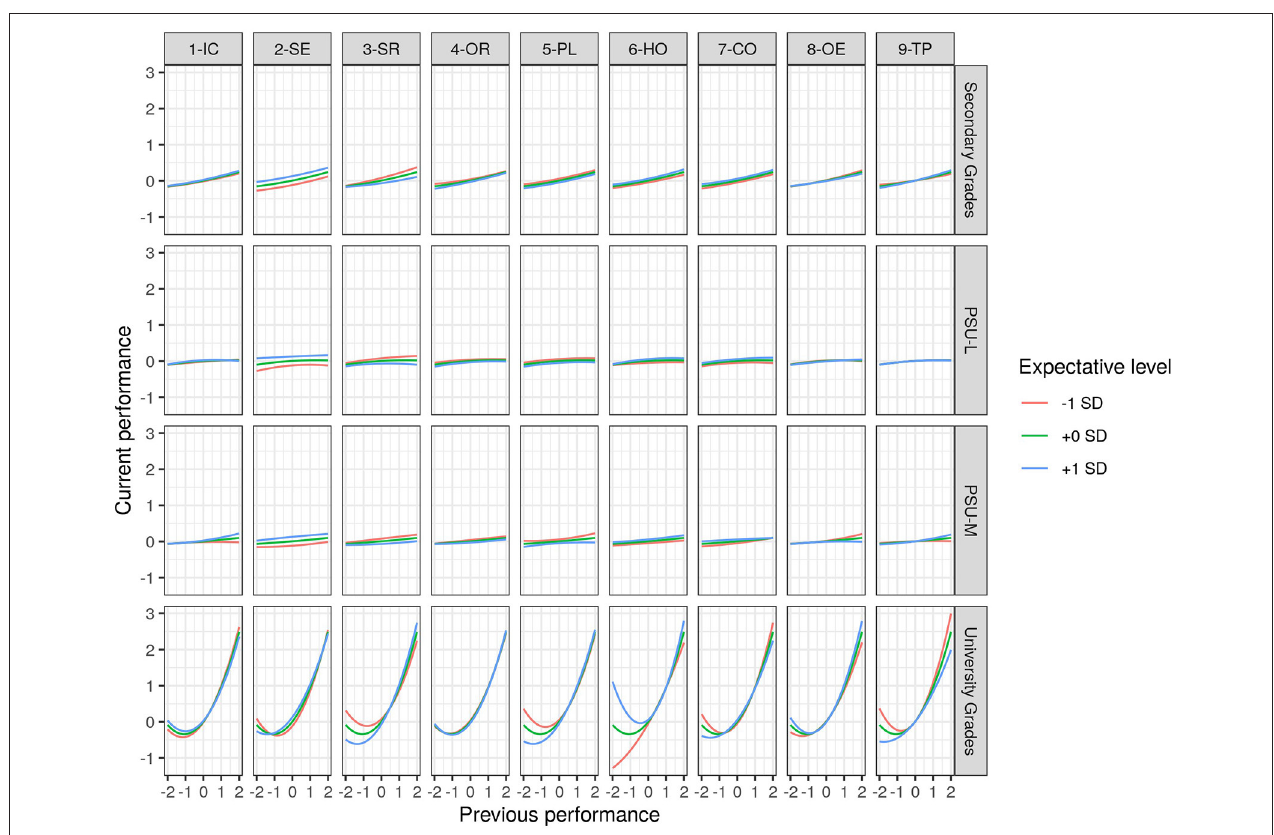
FIGURE 1 | Moderation of expectations in the relationship between previous and current performance.